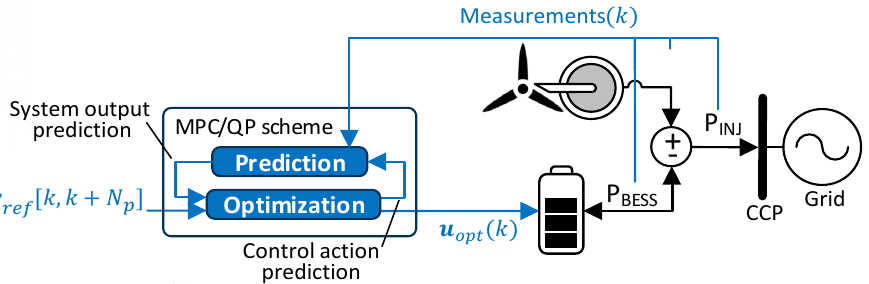
Figure 18. Model predictive control with quadratic programming (MPC/QP) strategy